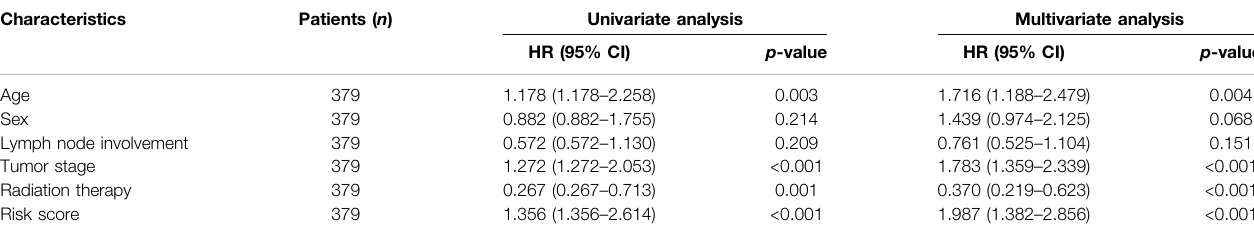
TABLE 2 | Prognostic potential of clinical features and the lncRNA risk score in gastric cancer. Characteristics